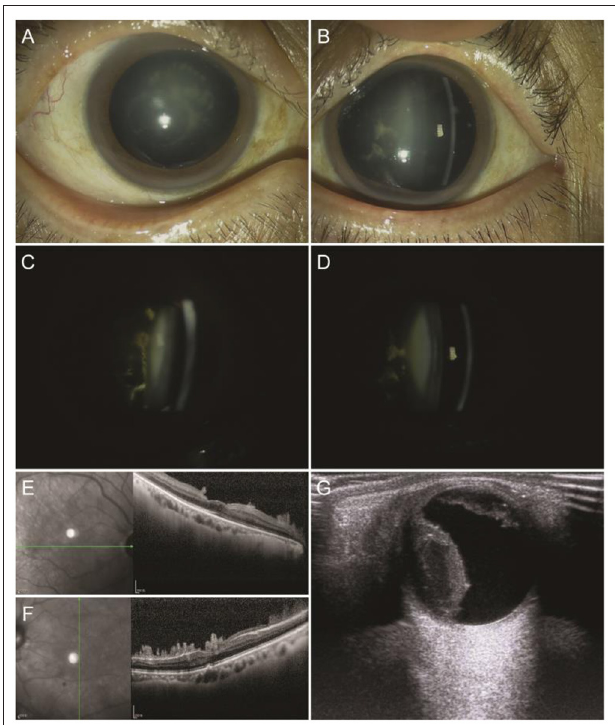
FIGURE 4 | Images of the recurrent vitreous amyloidosis. Anterior segment images showed opaque nuclear with white heterogeneous opacity adhered to the posterior lens capsule. Optical coherence tomography (OCT) showed fern-like material adhering to the posterior pole retina surface. (A,C,E) Right eye; (B,D,F) left eye. (G) Color-Doppler ultrasound showed a dome shape temporal elevation of the retina with increased echo density in the right